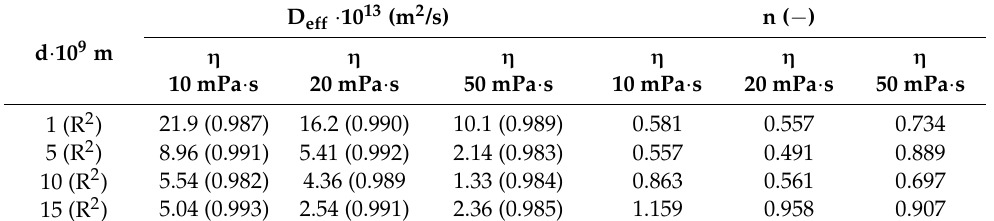
Table 1. Values of the effective diffusion coefficient, D eff , and the n parameter.